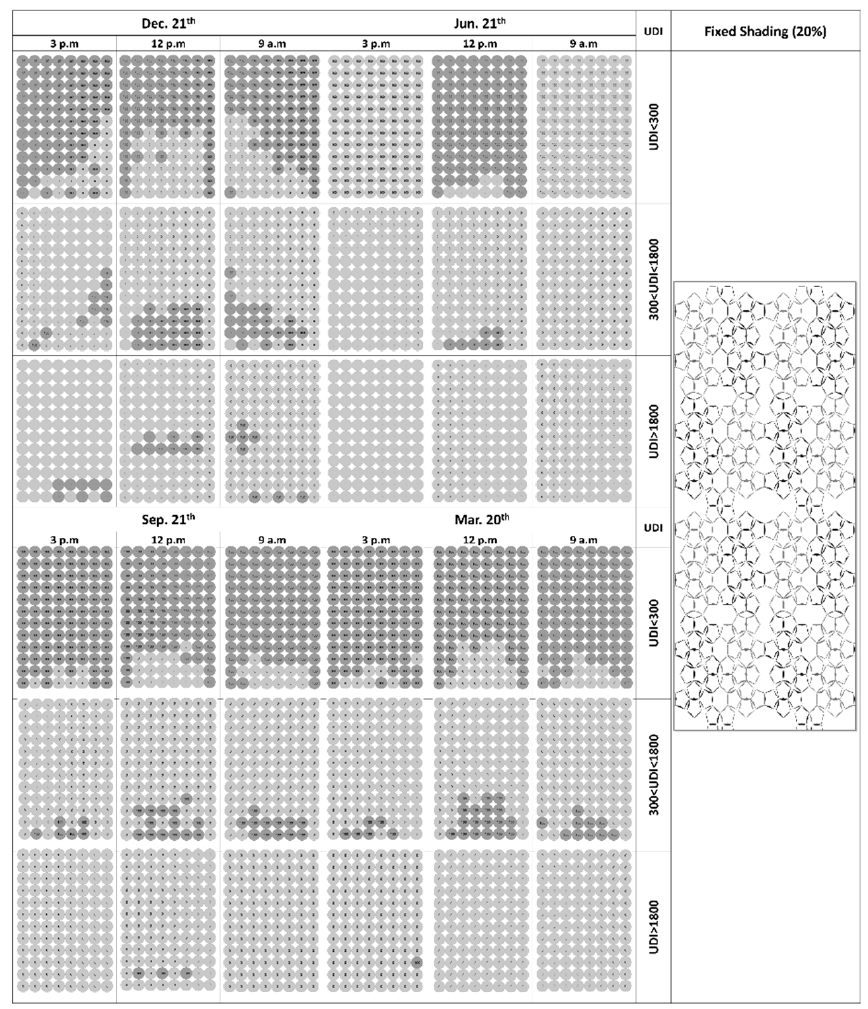
Figure 11. Useful Daylight Illuminance of critical days in the model with shading device type 1.